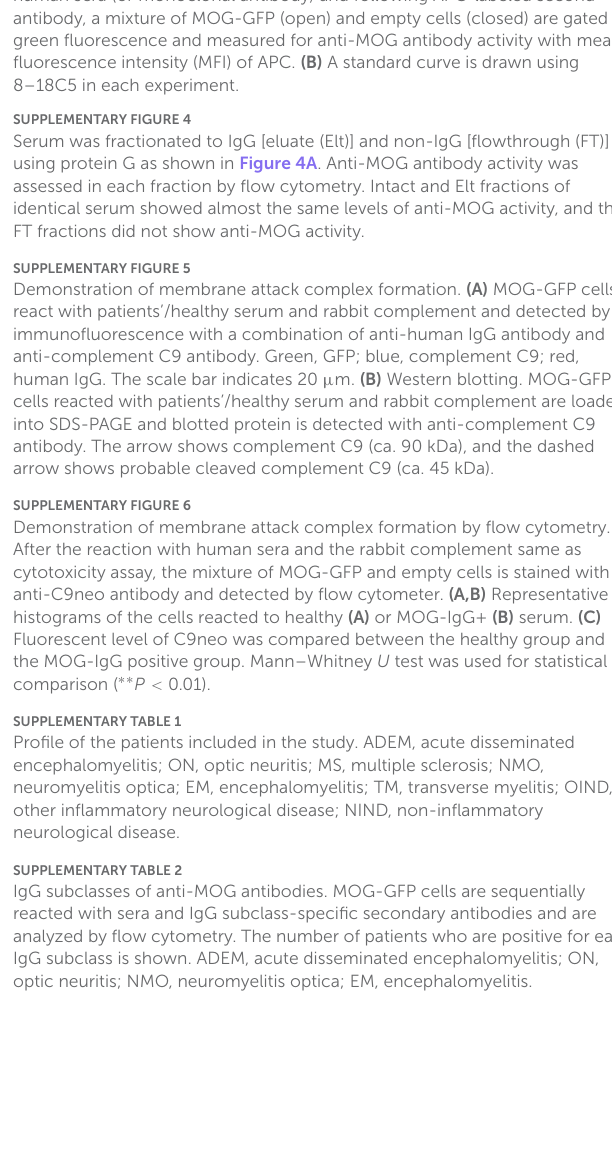
SUPPLEMENTARYFIGURE3 Detection of anti-MOG activity by flow cytometry. (A) After reaction with human sera (or monoclonal antibody) and following APC-labeled second antibody, a mixture of MOG-GFP (open) and empty cells (closed) are gated by green fluorescence and measured for anti-MOG antibody activity with mean fluorescence intensity (MFI) of APC. (B) A standard curve is drawn using 8–18C5 in each experiment. SUPPLEMENTARYFIGURE4 Serum was fractionated to IgG [eluate (Elt)] and non-IgG [flowthrough (FT)] using protein G as shown in Figure 4A . Anti-MOG antibody activity was